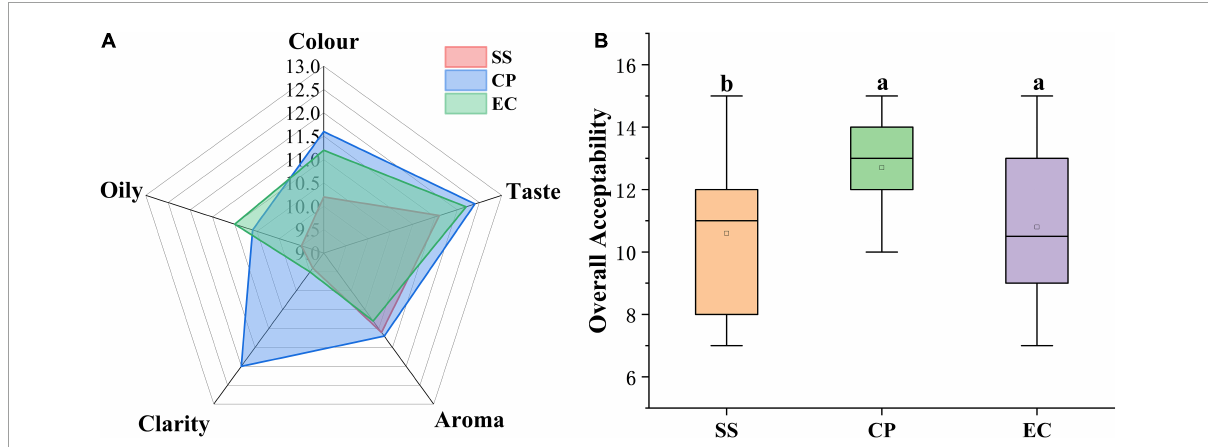
FIGURE3 Radar chart of sensory evaluation (A) and boxplot of overall acceptability (B) of Clitocybe squamulose chicken soup. The different lowercase letters denote statistical